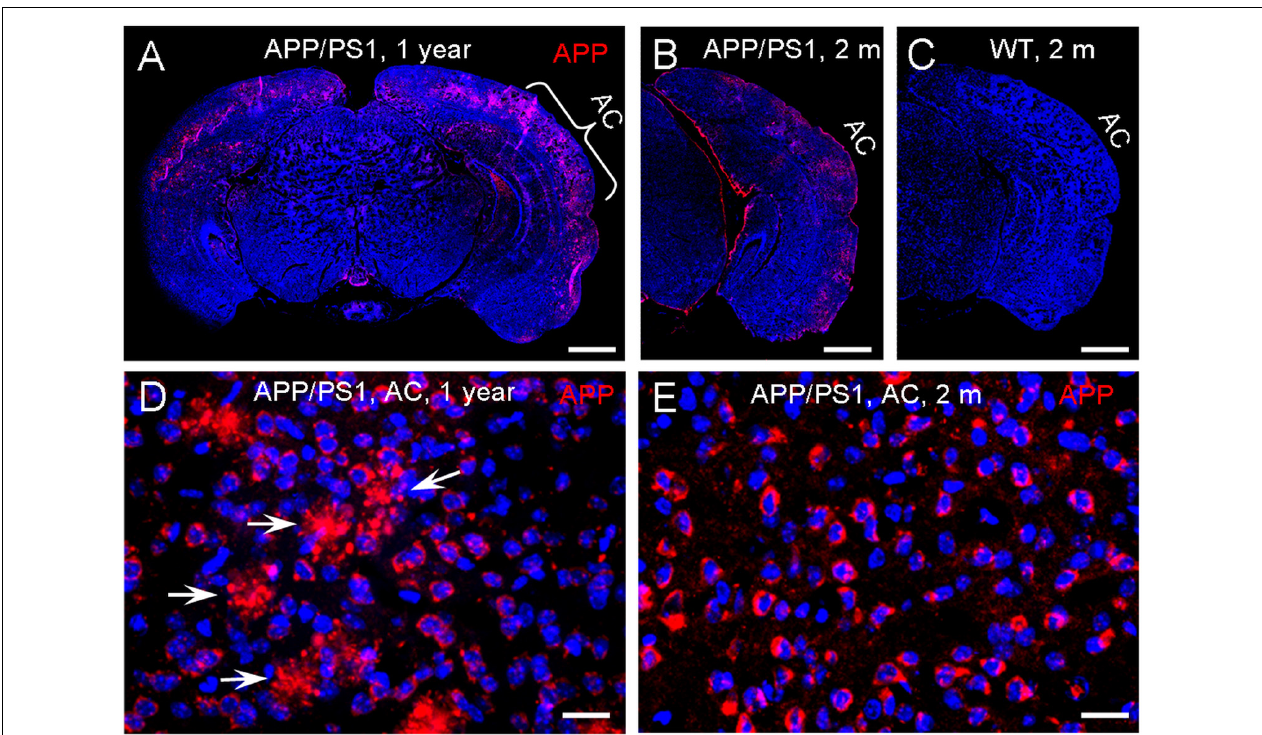
FIGURE 8 | Expression of amyloid precursor protein (APP) in the auditory cortex (AC) in APP/PS1 AD mice. (A–C) Immunofluorescent staining of brain slices in APP/PS1 AD mice and WT mice at the ages of 2 and 12 months old. (D,E) High-magnitude images of positive labeling in the AC area. The positive labeling is visible at the AC area in the APP/PS1 AD mouse at 2 months old. White arrows indicate plaque deposits in the AC area at the 12 months old mouse. Scale bar: 100 µ m in (A–C) , 10 µ m in (D,E)